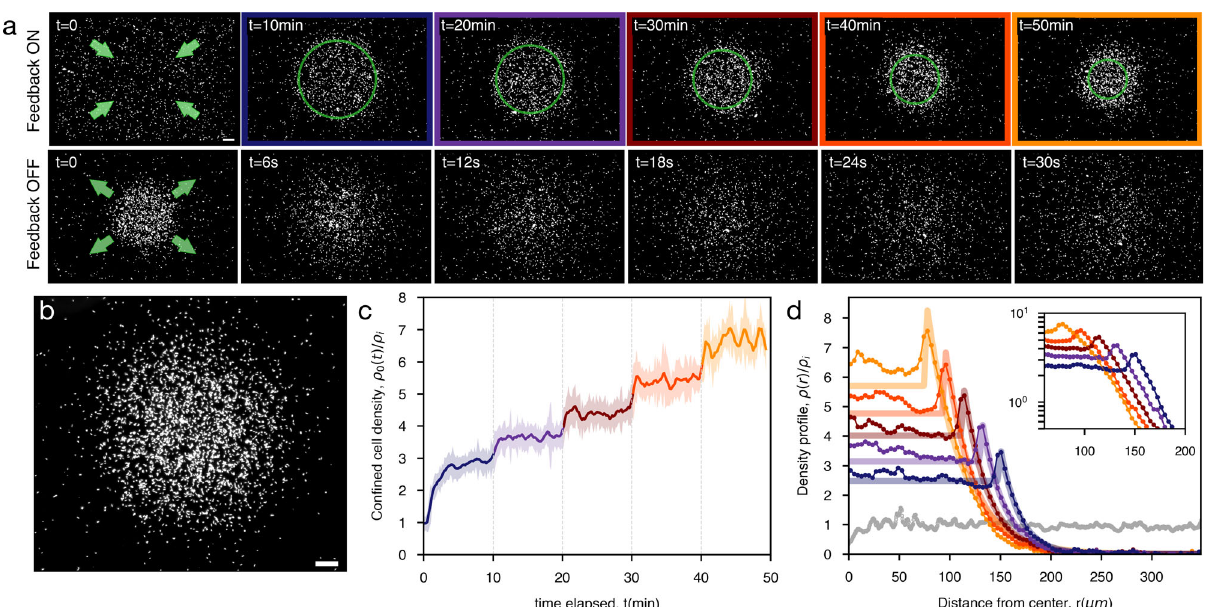
Fig. 4 Optical con fi nement of highly motile bacteria. Using the optical feedback loop with a radial transformation we con fi ne bacteria in circular regions of radii a that are progressively shrunk every 10 min. Different colors correspond to different a = 145, 127, 109, 91, 73 μ m At the end of the experiment, the feedback loop is turned off. Parameters are Δ = 1.8 μ m, R = 2 μ m, τ = 0.1 s, v 1 = 10 μ m s − 1 and v 0 = 5 μ m s − 1 . See Supplementary Movie 2. a Assembly and disassembly of con fi nement. Dark- fi eld microscope images at different times of bacteria accumulating towards the central circle of different a . Scale bar is 100 μ m. b Steady state of con fi ned bacteria. Feedback loop parameters are Δ = 3.3 μ m, R = 2.7 μ m, τ = 0.1 s, a = 91 μ m, v 1 = 10 μ m s − 1 and v 0 = 5 μ m s − 1 . Scale bar is 40 μ m. See Supplementary Movie 3. c Corresponding evolution along time of the density inside the circle ρ 0 , for r < a . Dotted gray lines indicate when a changes. d Stationary state pro fi les for the different a , each averaged over 5 min. Gray points are the initial state. Thick lines are fi ts to the theoretical Eq. (10), with an average resulting decay length of 1/ k = 24 ± 2 μ m. Error bars (standard error of the mean) are smaller than the symbol size. Inset shows the data in a semi-log plot.